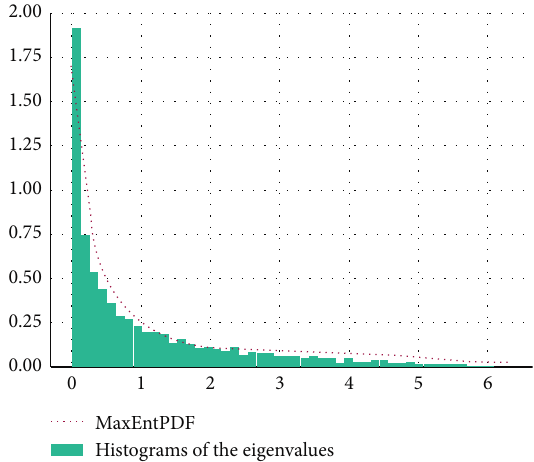
Figure 5: d � 1000, n � 1000, alpha � 0.5, and beta � 0.3.